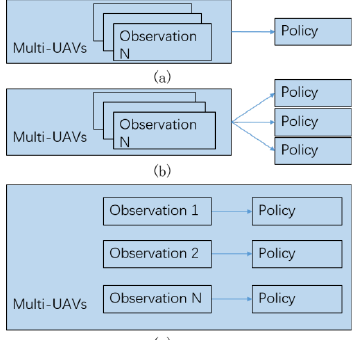
Figure 2. Multi-agent policy, ( a ) represents shared parameters, ( b ) represents centralized evaluation and decentralized execution, and ( c ) represents independent policies.